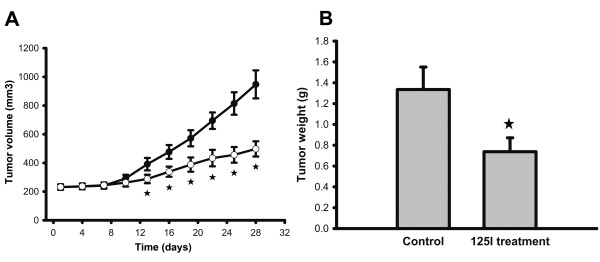
 Effect of 125I seed irradiation on the tumor volume and tumor weight. (A) Tumor volumes. (B) Tumor weight. Data are the mean ± SD and analyzed by the Mann–Whitney U test (☆: P < 0.05).